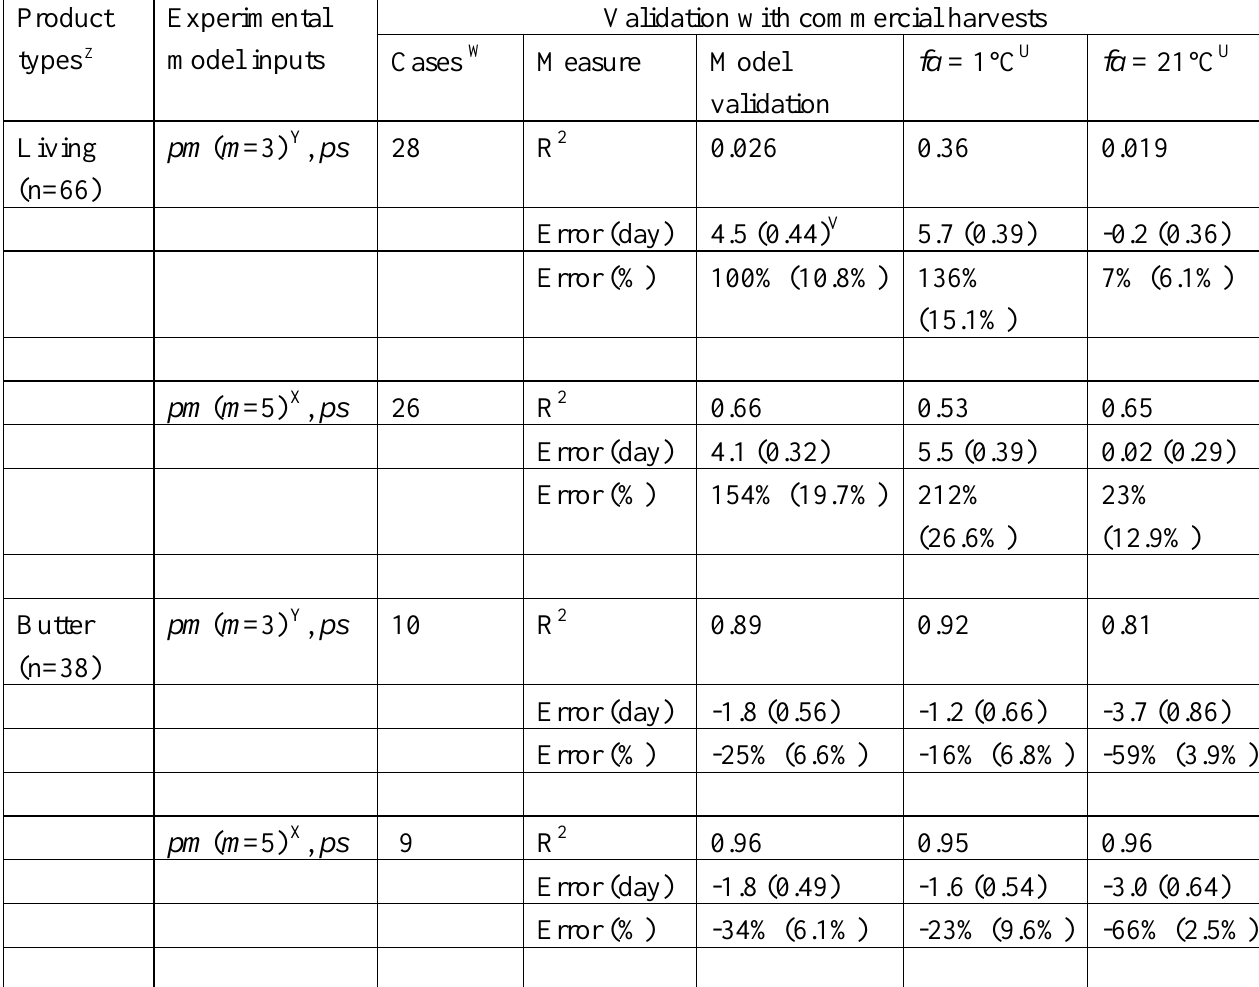
Table 1. Validation of 2-stage NN experimental models with commercial harvests for predicting remaining shelf life (RSL in days) of living and butter